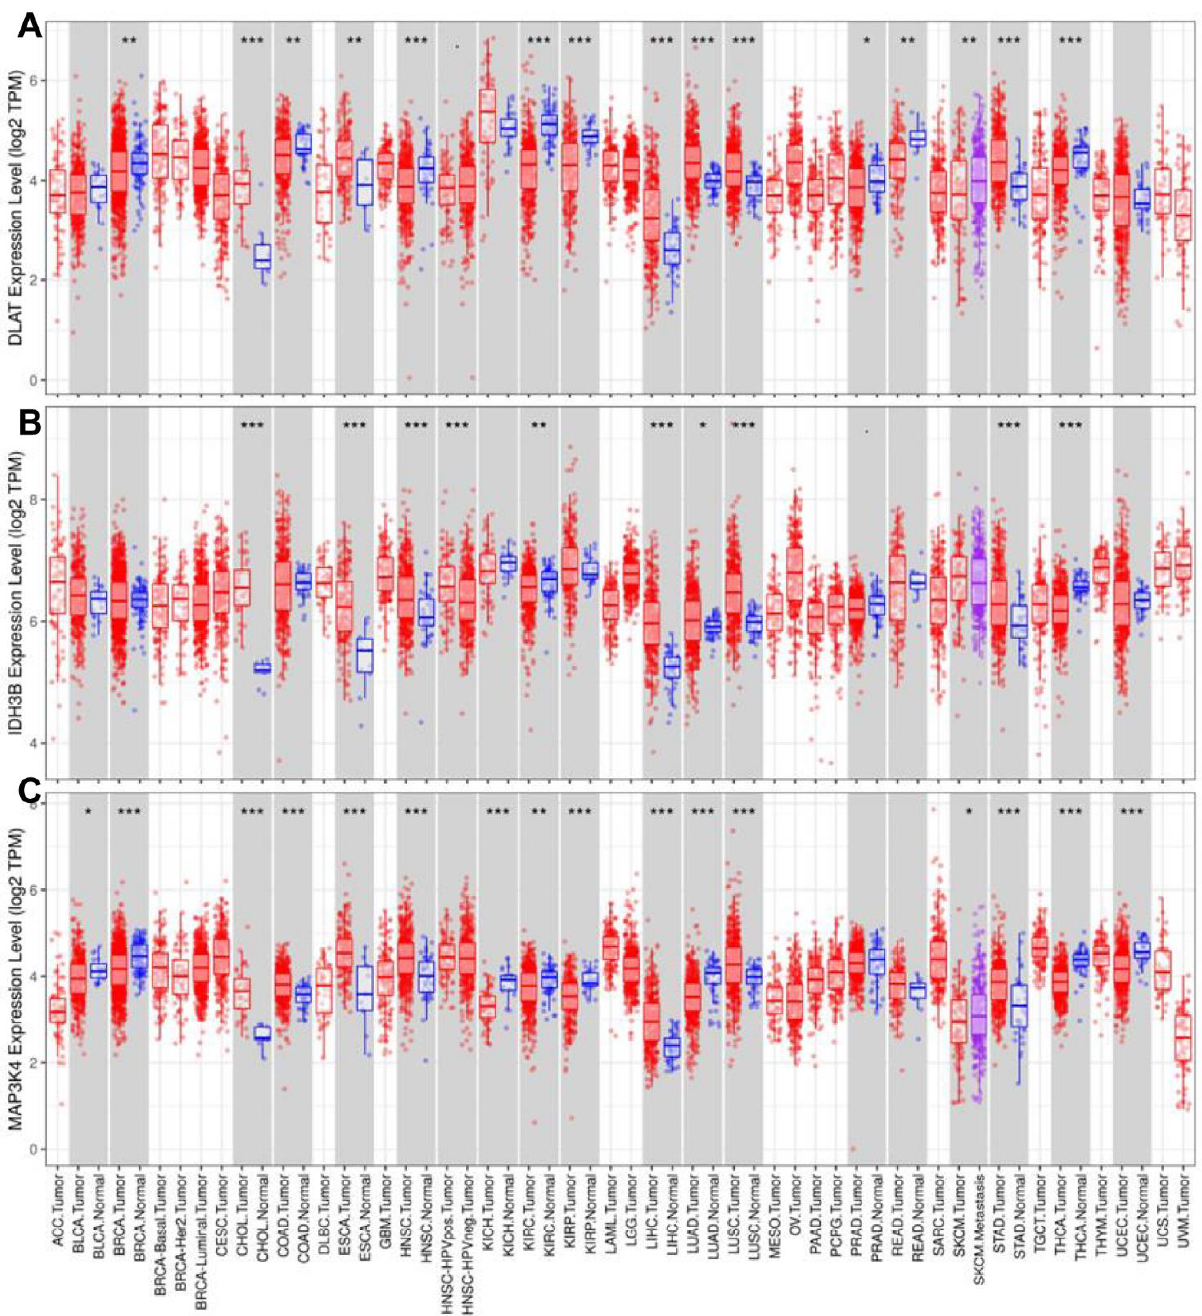
Figure 9. Analysis of expression levels in pan-cancer. The expression levels of DLAT ( A ), IDH3B ( B ), and MAP3K4 ( C ). * p < 0.05, ** p < 0.01, *** p < 0.001. Mutation data of DLAT, IDH3B, and MAP3K4 were analyzed and visualized in the GSCA online tool. The landscape of mutation in each cancer sample was presented in the